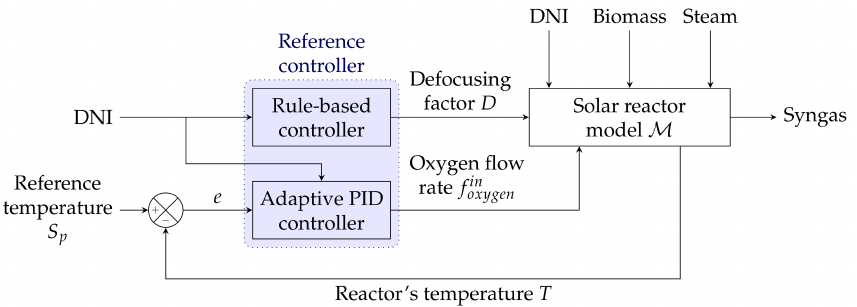
Figure 9. The reference controller, defined as a combination of an adaptive PID controller with optimized gains (for the oxygen flow rate f in oxygen ) and a rule-based controller (for the defocusing factor D